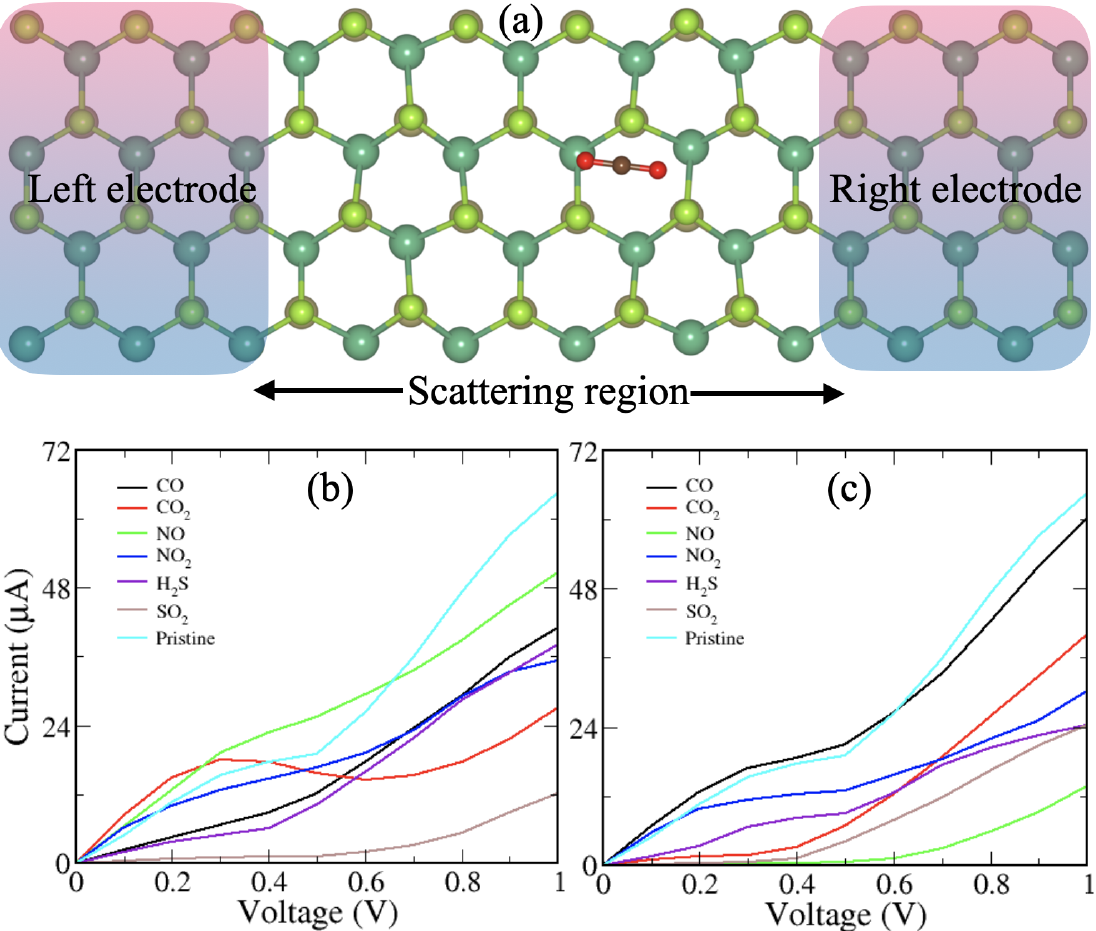
Figure 6. ( a ) Schematic representation of the device model constituted by three parts: the semi-infinite left (L) and right (R) electrodes and scattering region. Current–voltage characteristics of the Janus NbSeTe monolayer for ( b ) gas molecules absorbed on the Se-side and ( c ) gas molecules absorbed on the Te-side.